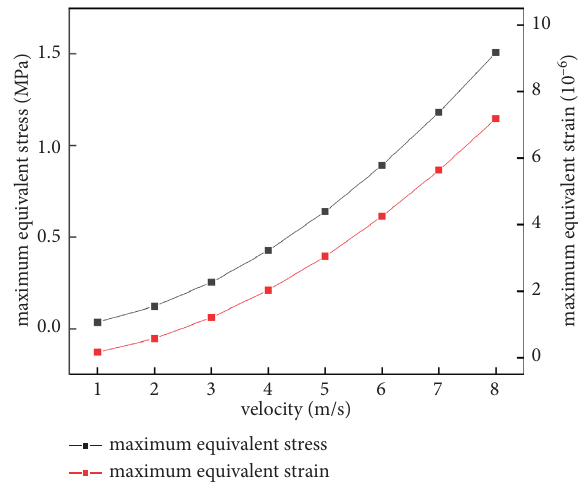
Figure 8: Variation curve of maximum equivalent stress and strain with drilling fluid velocity.